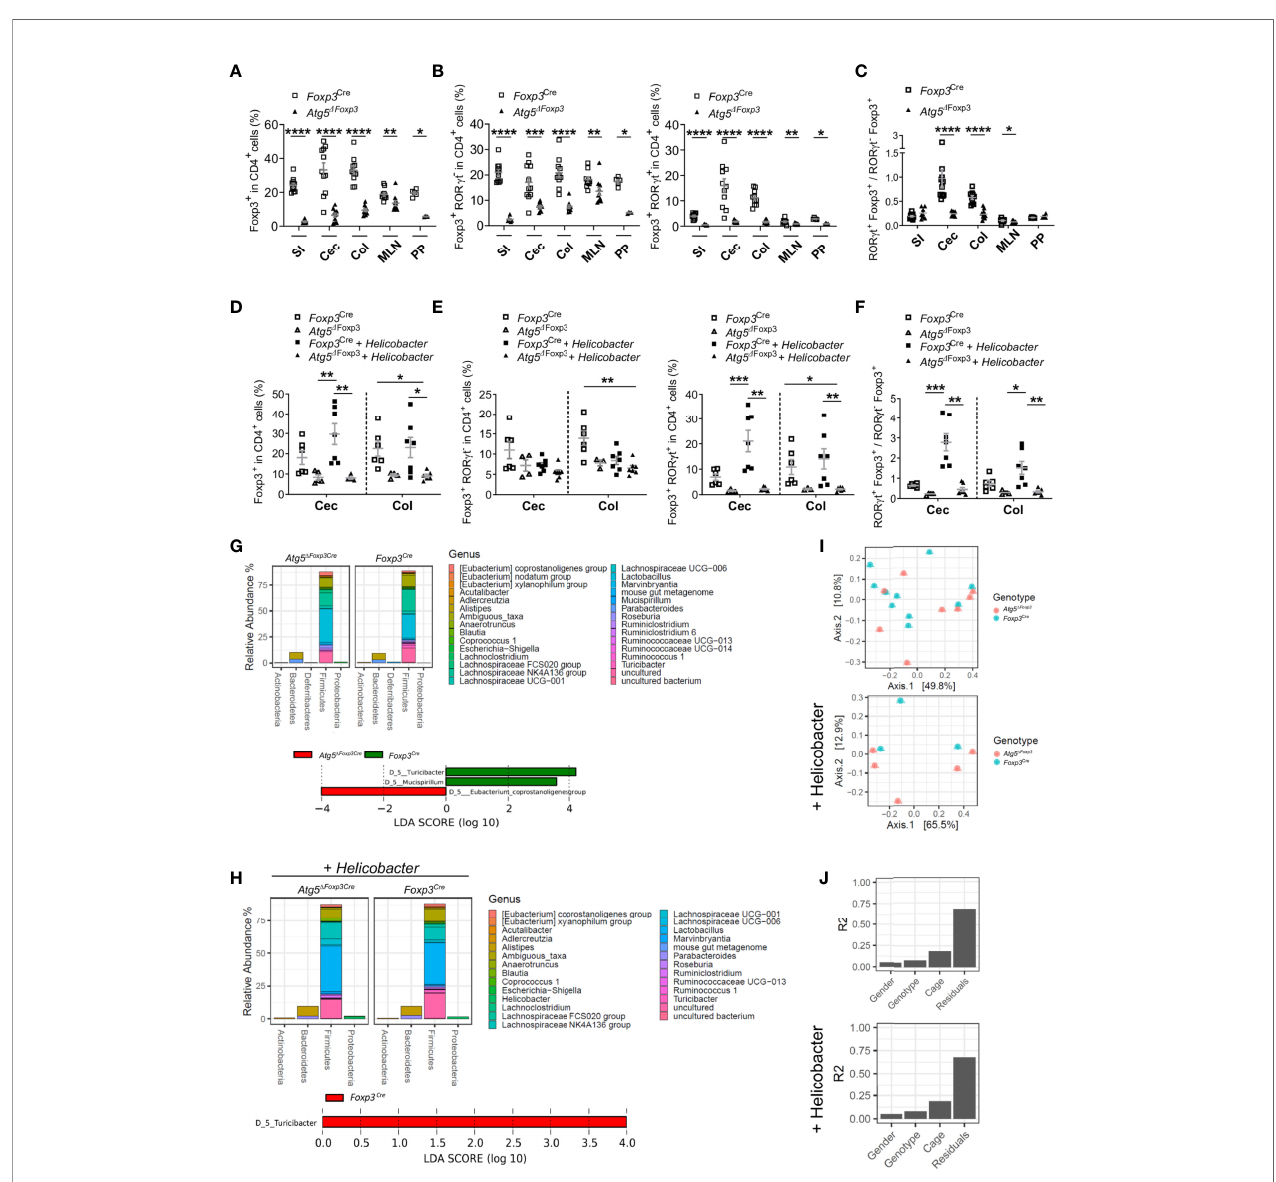
FIGURE 5 | Atg5 de fi ciency affects dramatically intestinal Foxp3 + ROR g t + Treg cells. (A) Frequencies of Foxp3 + cells within the CD4 + cell populations in small intestine (SI), cecum (Cec), colon (Col), mesenteric lymph nodes (MLN) and Peyer´s patches (PP) of Foxp3 Cre and Atg5 D Foxp3 mice. (B) Frequencies of Foxp3 + ROR g t - cells (left) and Foxp3 + ROR g t + (right) within the CD4 + cell populations in small intestine (SI), cecum (Cec), colon (Col), mesenteric lymph nodes (MLN) and Peyer´s patches (PP) of Foxp3 Cre and Atg5 D Foxp3 mice. (C) Ratio of Foxp3 + ROR g t + and Foxp3 + ROR g t - cells in small intestine (SI), cecum (Cec), colon (Col), mesenteric lymph nodes (MLN) and Peyer´s patches (PP) of Foxp3 Cre and Atg5 D Foxp3 mice. Mean ± SEM are given. (D) Frequencies of Foxp3 + cells within CD4 + cells in cecum (Cec) and colon (Col) of Foxp3 Cre and Atg5 D Foxp3 mice under speci fi c-pathogen-free conditions and colonized with Helicobacter species. (E) Frequencies of Foxp3 + ROR g t - cells (left) and Foxp3 + ROR g t + (right) cells within the CD4 + cell populations in cecum (Cec) and colon (Col) of Foxp3 Cre and Atg5 D Foxp3 mice under speci fi c- pathogen-free conditions and colonized with Helicobacter species. (F) Ratio Foxp3 + ROR g t + vs . Foxp3 + ROR g t - cells in cecum (Cec) and colon (Col) of Foxp3 Cre and Atg5 D Foxp3 mice under speci fi c-pathogen-free conditions and colonized with Helicobacter species. (G) Representation of relative abundances of bacterial genus (top) and analysis of differentially abundant bacterial genus by LEfSe (linear discriminant analysis effect size) (bottom) present in fecal microbiota of Foxp3 Cre and Atg5 D Foxp3 mice under speci fi c-pathogen-free conditions using 16S rRNA sequencing (H) Representation of relative abundances of bacterial genus (top) and analysis of differentially abundant bacterial genus by LEfSe (linear discriminant analysis effect size) (bottom) present in fecal microbiota of Foxp3 Cre and Atg5 D Foxp3 mice colonized with Helicobacter using 16S rRNA sequencing. (I) Analysis of b -diversity (principal coordinates analysis (PCoA)) and (J) permutational multivariate analysis of variance (ADONIS) of fecal microbiota from Foxp3 Cre and Atg5 D Foxp3 mice under speci fi c-pathogen-free conditions (top) and colonized with Helicobacter (bottom) using 16S rRNA sequencing. (A – C) Statistical analyses were performed by two-tailed Mann-Whitney tests. (D – F) The Kruskal – Wallis one-way ANOVA tests were used for statistical analysis. (A – F) Mean ± SEM are given. Each symbol represents a single mouse in the scatter plots. *p < 0.05, **p < 0.01, ***p < 0.001, ****p <